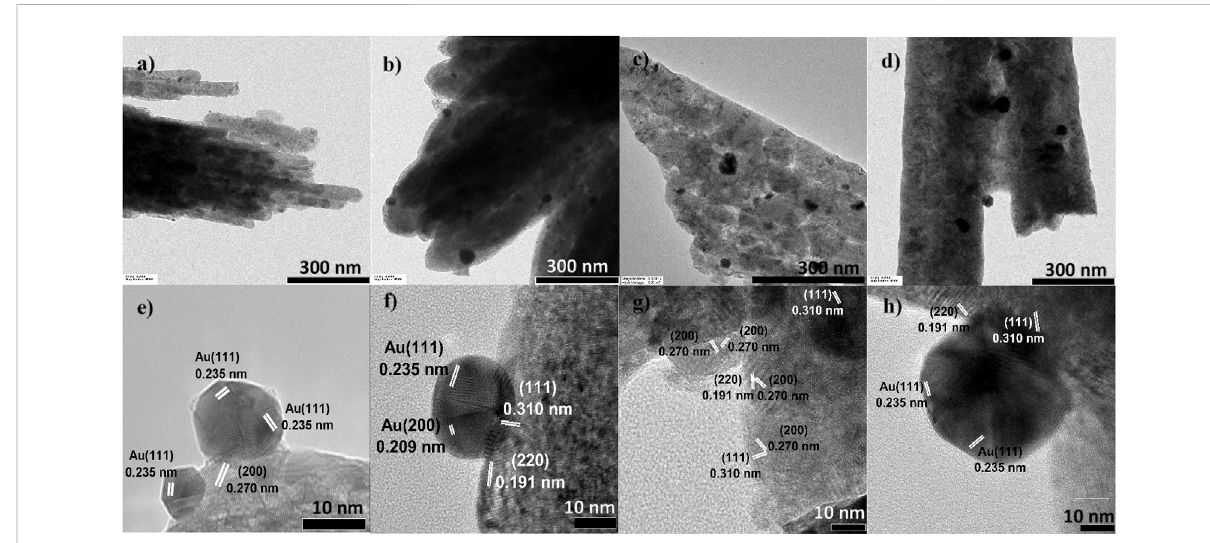
FIGURE 4 Representativehigh-resolutiontransmissionelectronmicroscopyimagesof (A,E) Au/CeO 2 120 (B,F) Au/CeO 2 140 (C,G) Au/CeO 2 160,and (D,H) Au/CeO 2 180. CeO 2 X: cerium oxide obtained at a value X for the temperature of the preparatory hydrothermal process; Au/CeO 2 X: CeO 2 X-supported gold